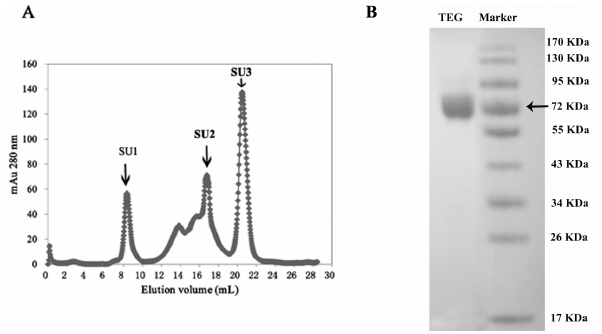
Figure 2. ( A ) Gel-filtration on Superdex 75 HR10/30 column. SU1, SU2 and SU3 stand for the three eluted fractions Fraction SU1 representing purified α -galactosidase; ( B ) Sodium dodecyl sulfate polyacrylamide polyacrylamide gelelectrophoresis (SDS-PAGE) results: Left lane: purified α - galactosidase. Right lane: molecular mass standards. The molecular mass of SU1 was 72 kDa. SDS-PAGE of the enzyme was conducted and the band corresponding to the purified protein was excised and identification of partial amino acid sequences by electrospray ionisation tandem mass spectrometry (ESI-MS/MS) was carried out. Amino acid sequences of two internal peptide fragments. Peptide 1: LGGAAGTNLEAR and Peptide 2: FSNLDIDSAGR were obtained. The effect of pH on TEG was determined using pNPGal as the substrate. As shown in Figure 3A,B, TEG displayed the highest activity at pH 5.0, whereas no activity was detectable at pH 8.0. Furthermore, the enzyme was fairly stable over an acidic pH range of 2.0–6.0, retaining more than 65% of its activity after incubation for 120 min.